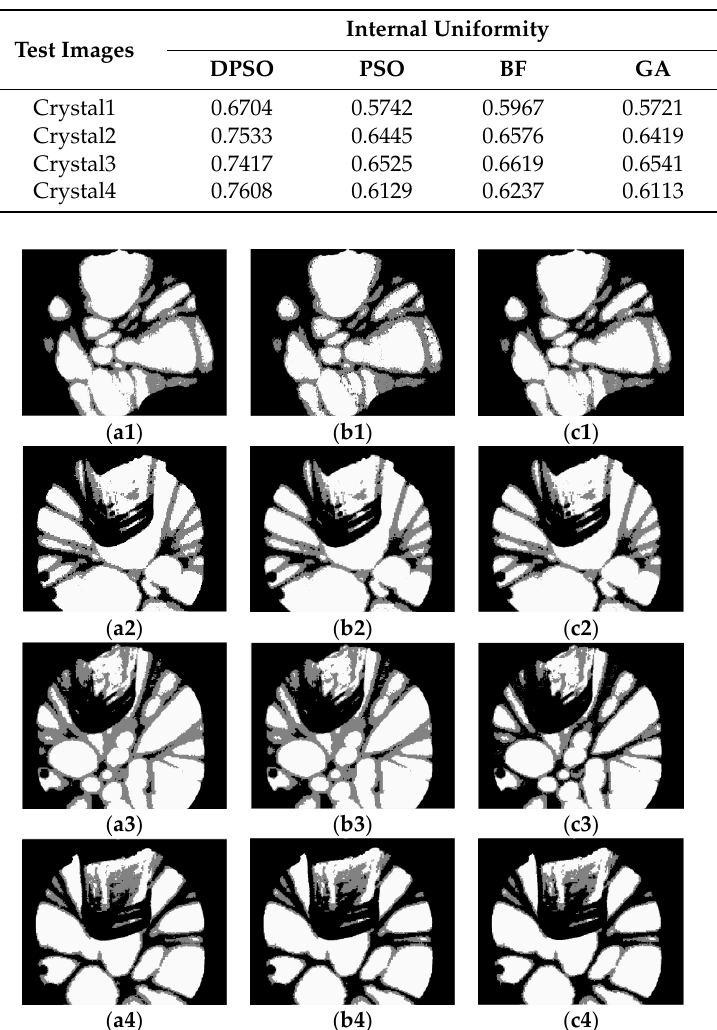
Figure 7. Segmented images obtained by the Otsu-based PSO, BF, and GA methods (( a1 – a4 , b1 – b4 , c1 – c4 ) represent PSO, BF, and GA, respectively).